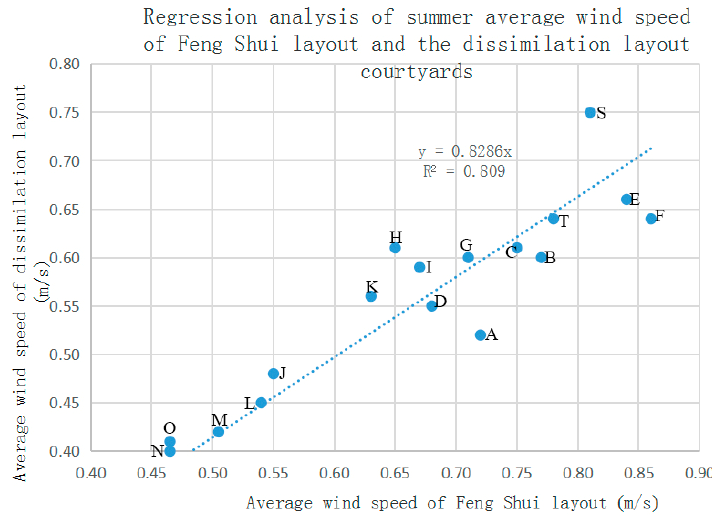
Figure 9. The regression analysis of the summer average wind speed for the courtyards of feng shui layout and dissimilation layout. The values of the figure was based on CFD simulation results.